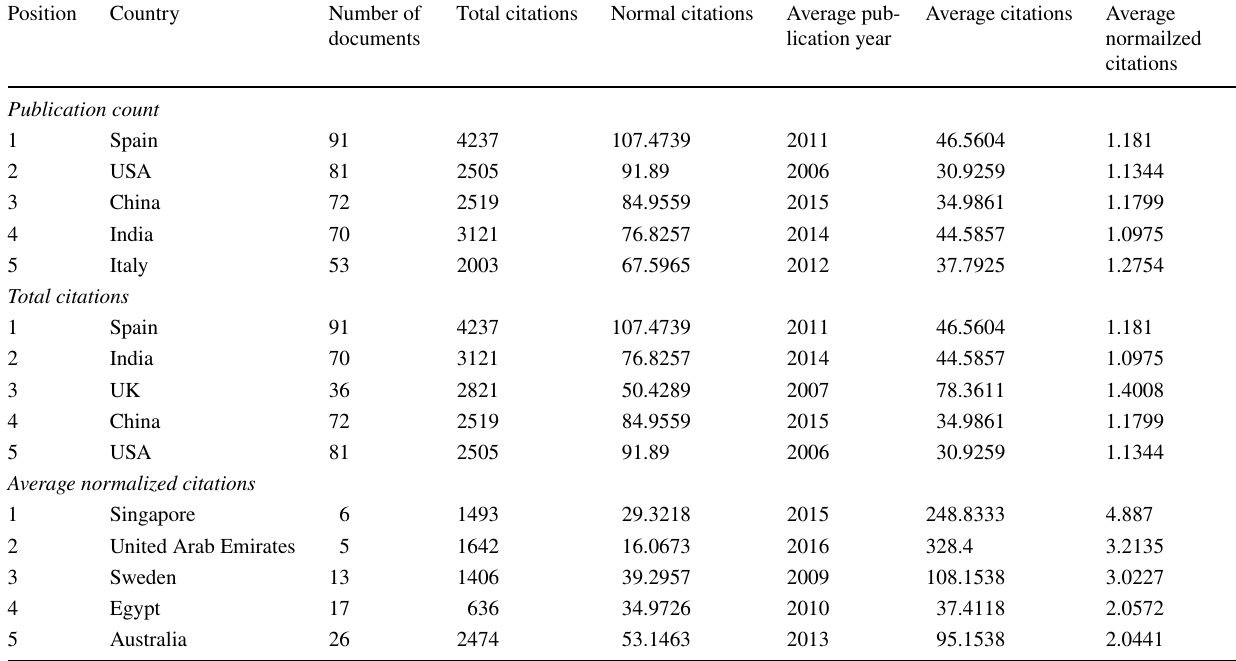
Table 2 List of leading 5 countries in terms of publication count, total citations and average normalized citations